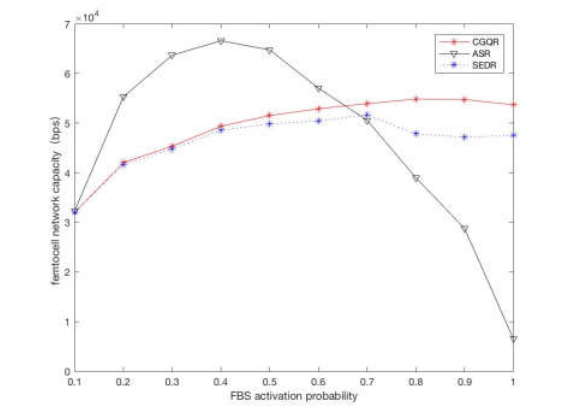
Figure 3. Average throughput with activation